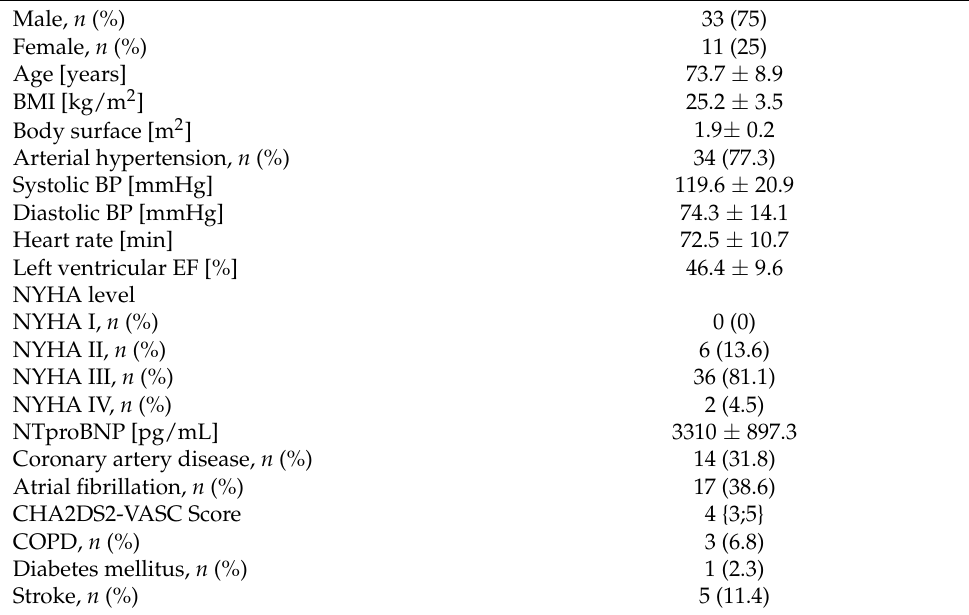
Table 1. Baseline characteristics of patients with cardiac amyloidosis.